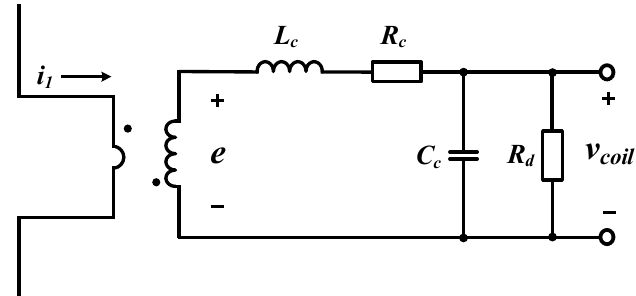
Figure 2. Equivalent lumped circuit of the pick-up coil.